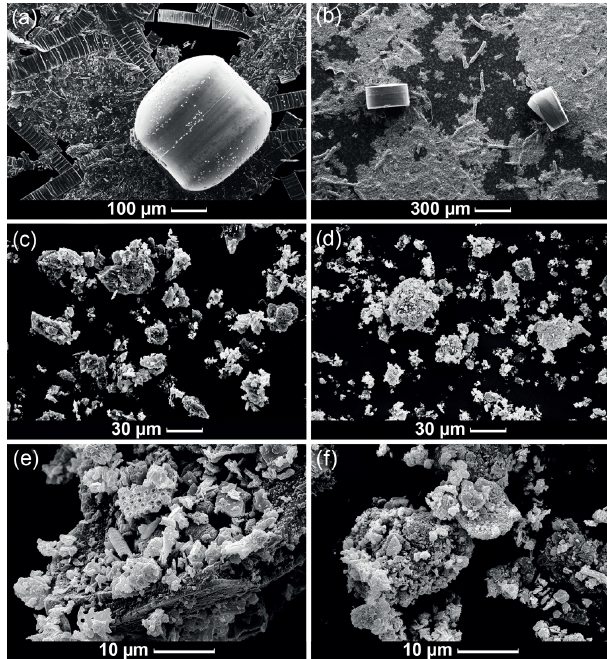
Figure 6. Scanning electron microscopy (SEM) photographs of two sediment trap samples before (a, b) and after grinding (c–f) . Panels (c) and (d) represent the average grain size of the ground samples, while (e) and (f) reveal details visible at 2500-fold